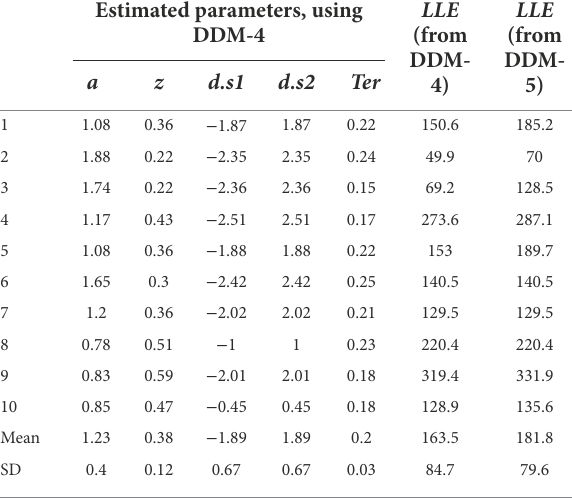
TABLE 6 Model comparison: Results of model-fitting with DDM-4; for ease of comparison, maximal LLE for each file under DDM-5 is also shown (reprinted from Table 4